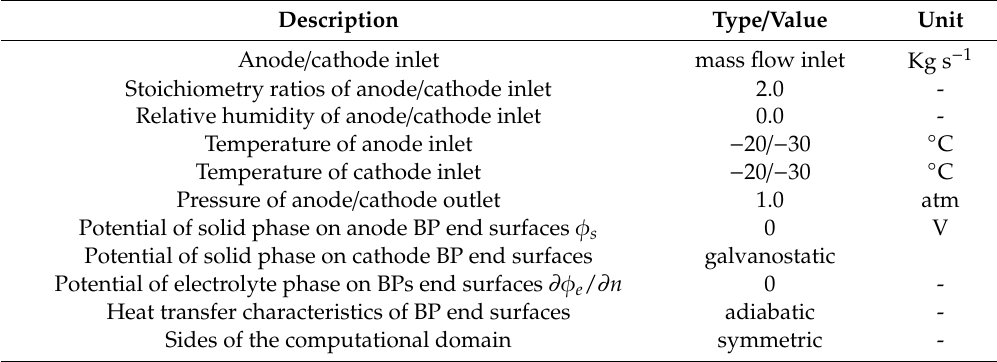
Table 2. The boundary conditions.